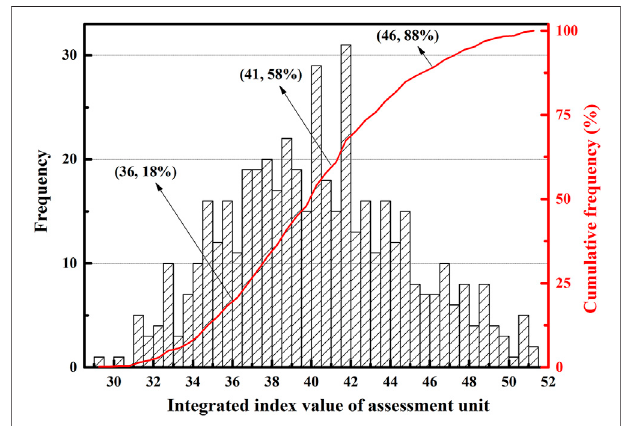
FIGURE 2 | Frequency distributions of the integrated index values for all assessment units of the eight glacier inventories.